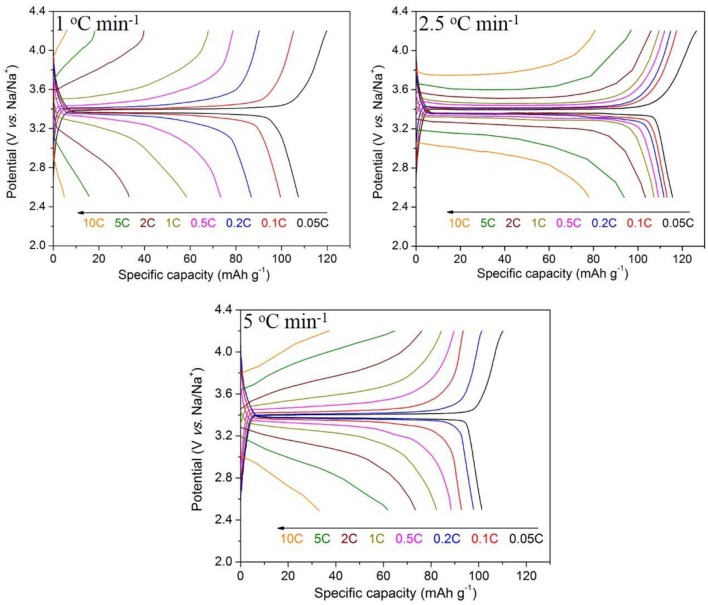
Charge/discharge curves of Na3V2(PO4)3/C synthesized at different heating rates.